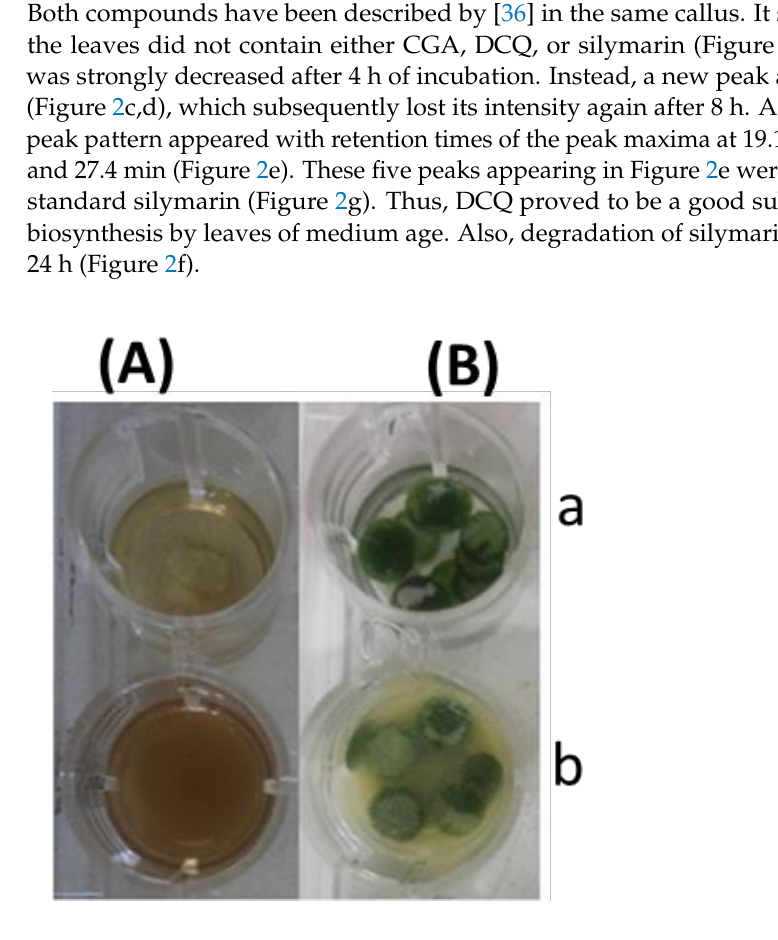
Figure 1. Bioconversion assay. ( A ) Reaction mixture of S. marianum leaf extract and callus extract ( B ) Leaf discs soaked with callus extract. (a) Control medium, (b) callus extract.